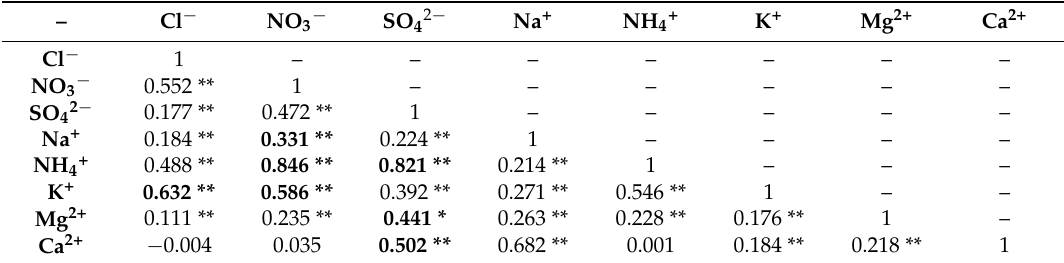
Table 5. Pearson correlation of the water-soluble ions in PM 2.5 in the